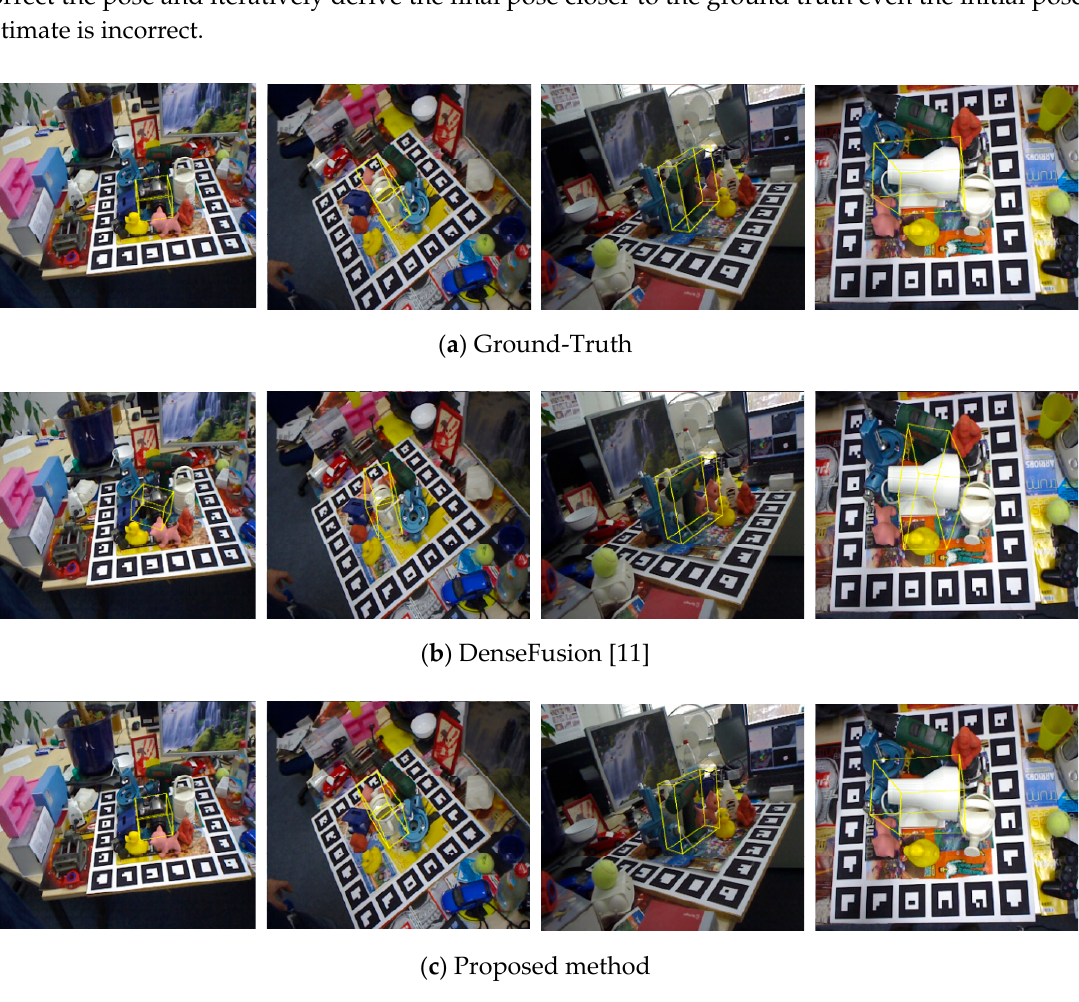
Figure 4. The object pose estimation results by yellow bounding box are drawn in the corresponding scene images according to the LINEMOD dataset. The name of the target objects in column from left to right are Cam, Can, Driller, and Lamp, respectively.